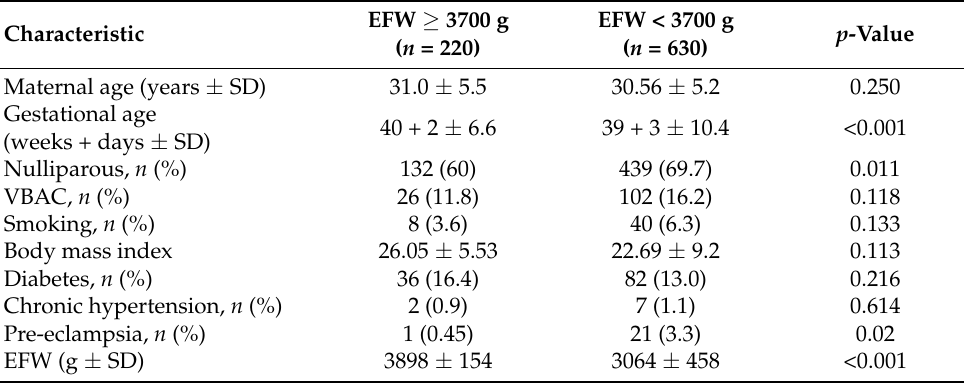
Table 1. Baseline characteristics in relation to sonographic EFW.